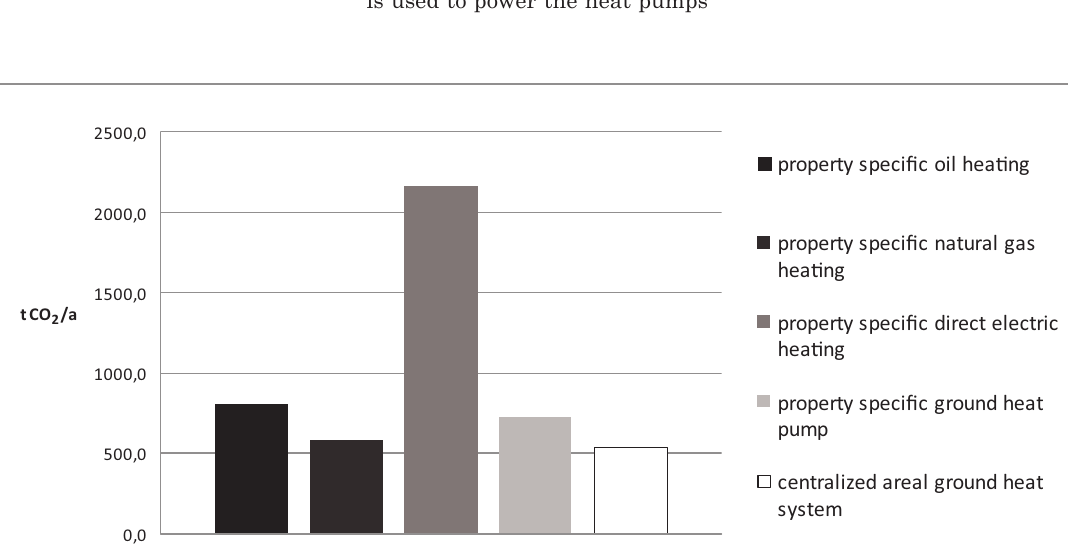
emissions in Nupurinkartano when Nordic mix electricity Figure 3. Yearly co 2 is used to power the heat pumps